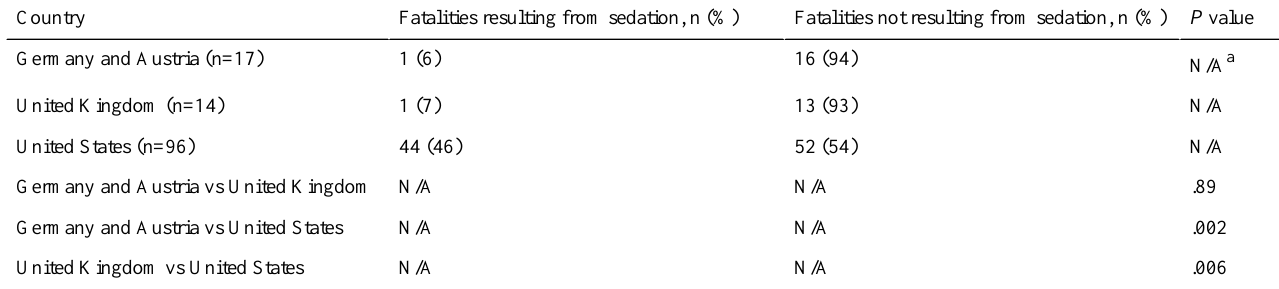
Table 8. Comparison of fatalities in dental facilities as a result of sedation reported in online publications with respect to country.